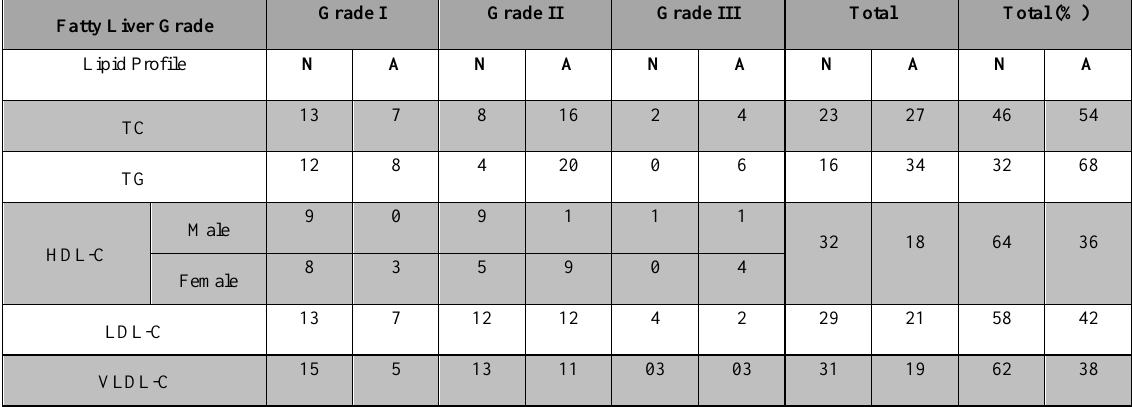
Table 2. Distribution of patients showing abnormal lipid profile in NAFLD.